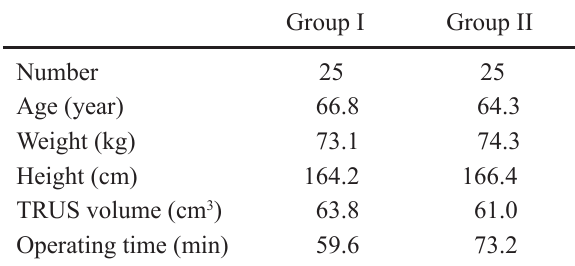
in any parameters (p >